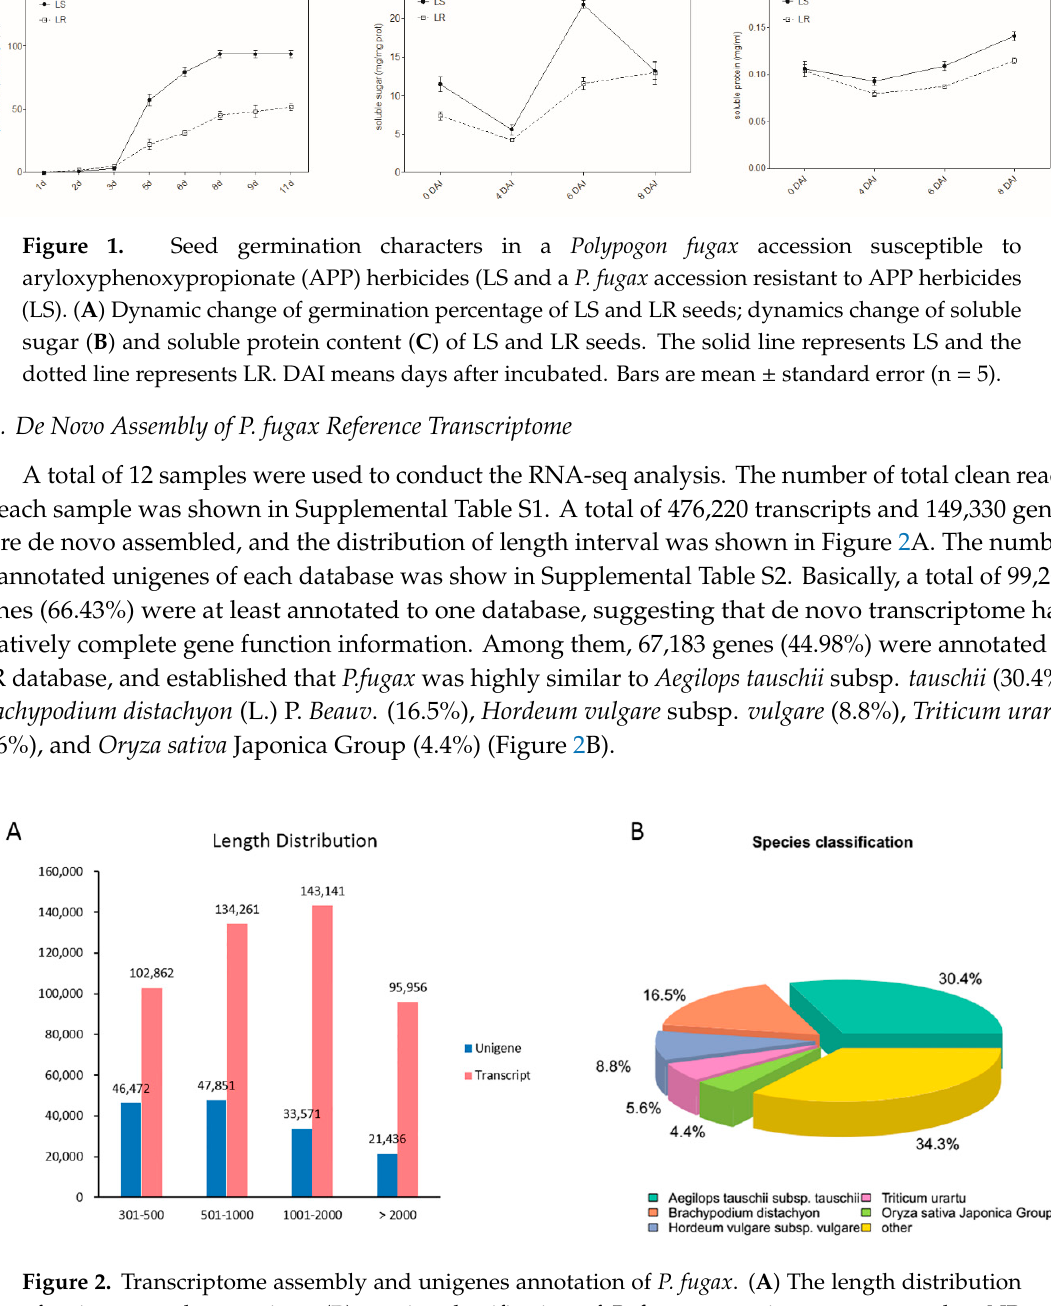
Figure 2. Transcriptome assembly and unigenes annotation of P. fugax . ( A ) The length distribution of unigenes and transcripts; ( B ) species classification of P. fugax transcriptome annotated to NR (NCBI non-redundant protein sequences) database. The numbers near the pie charts indicate the percentage of unigenes in each class.